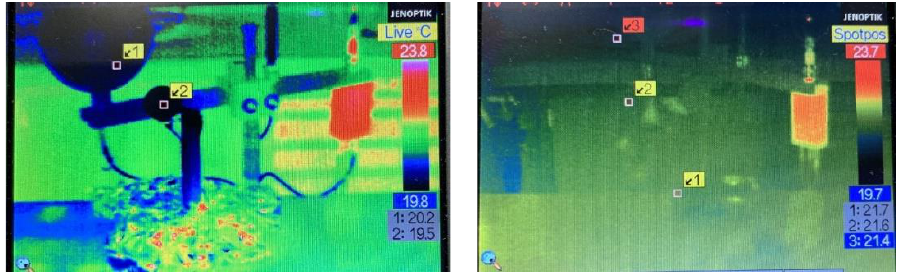
Figure A7. Infrared images of both devices during ambient condition ‘external gate opened’ ( left ) and ‘fan on’ ( right ).